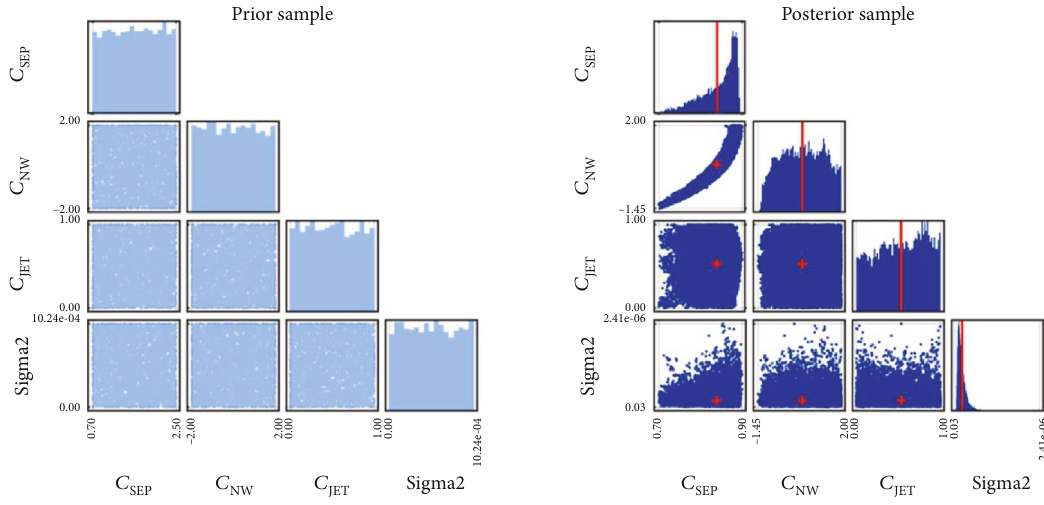
Figure 16: Prior and posterior distributions of SP (24-deg compression